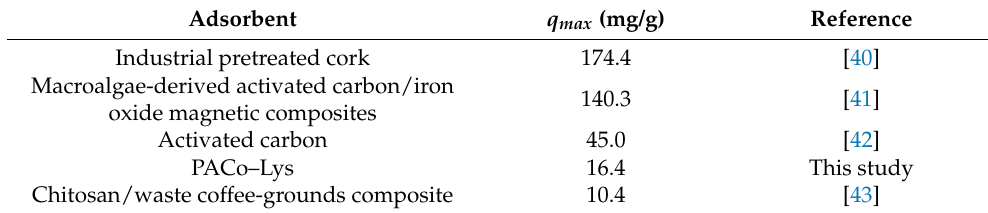
Table 5. Comparison of some adsorbents for ASA removal in terms of maximum adsorption capacity.